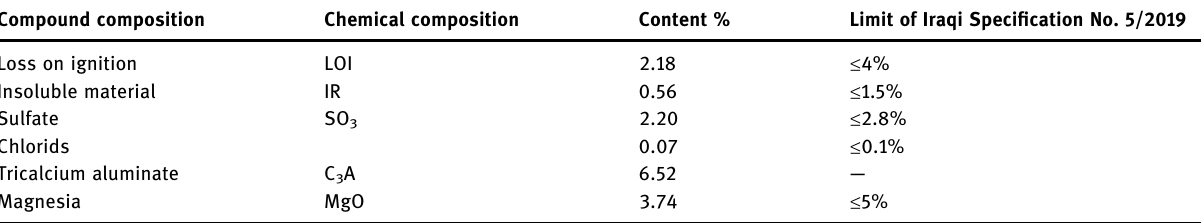
Table 2: Chemical composition and main compounds of cement* Compound